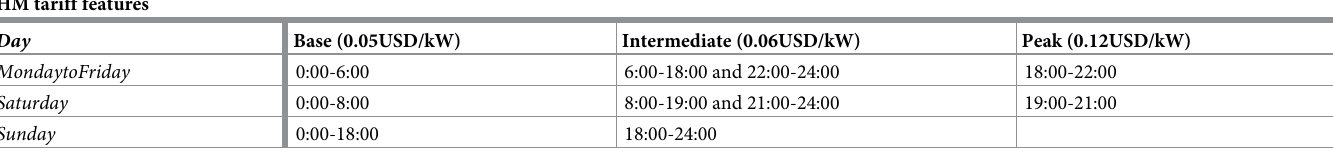
Table 2. HM region central